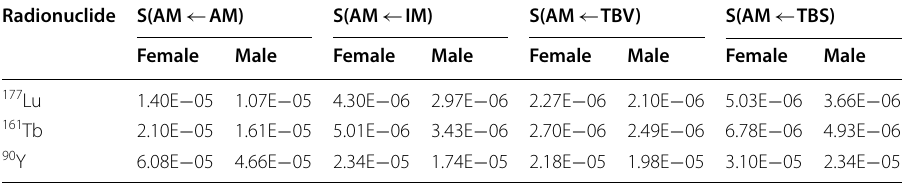
Table 3 Skeletal-averaged S-values (mGy/MBq-s) for lutetium-177, terbium-161, and yttrium-90 Radionuclide S(AM AM) S(AM IM) S(AM TBV) ← ← ←